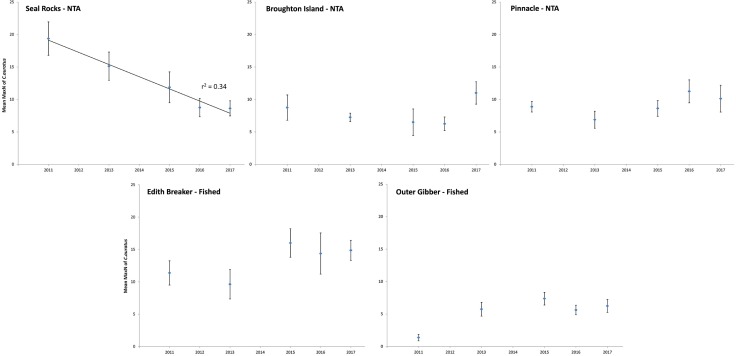
Changes through time (years) in mean relative abundance of C. auratus (+/- standard error) for each location.Goodness-of-fit measure for significant linear regression models indicated by r2 value.